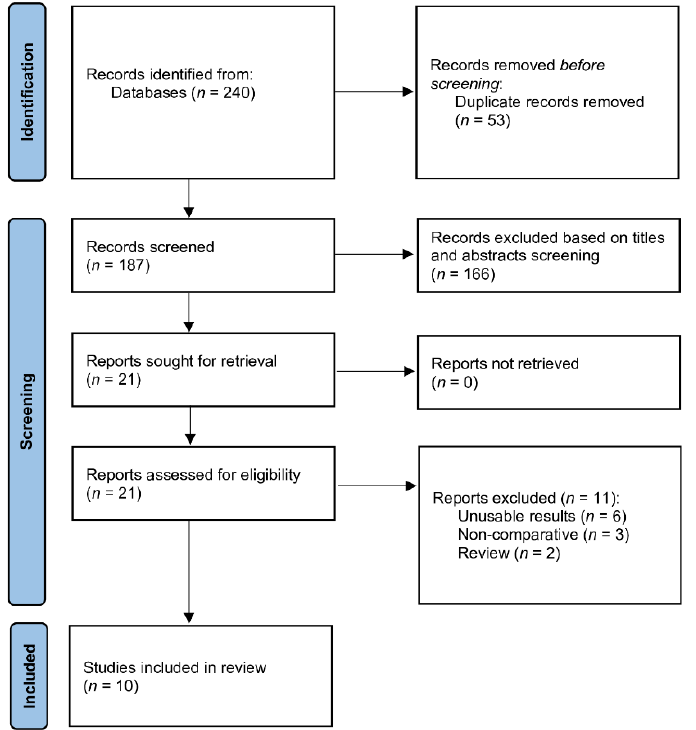
Figure 1. Forest plot of blood volume loss among TXA and non-TXA groups. The centre of each square represents the weighted mean differences for individual trials, and the corresponding horizontal line stands for a 95% confidence interval. The diamonds represent pooled results.